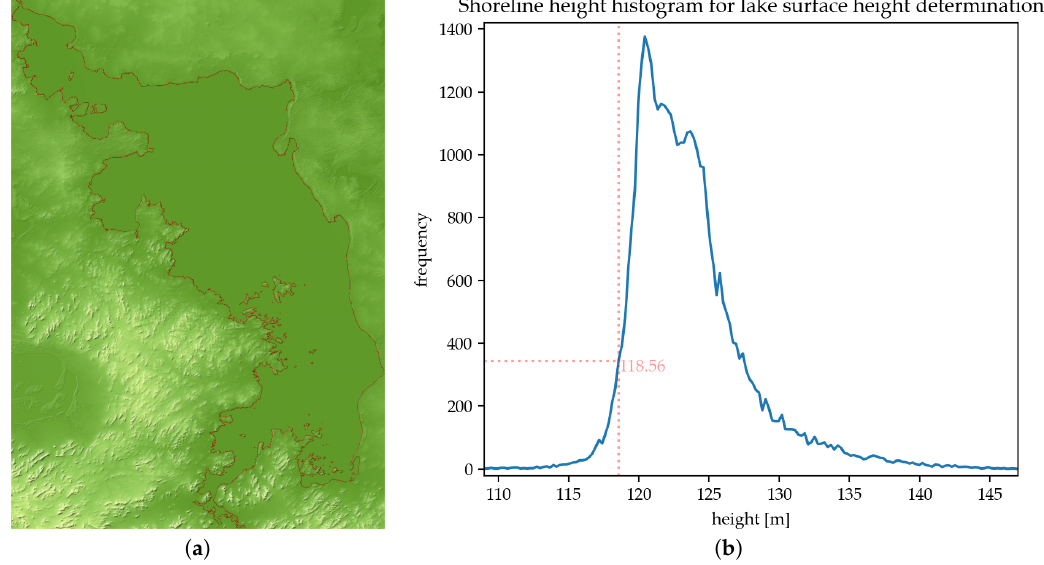
Figure 11. Lake Gairdner, Australia. ( a ) DEM and shoreline in red. ( b ) Histogram of the height of the shoreline